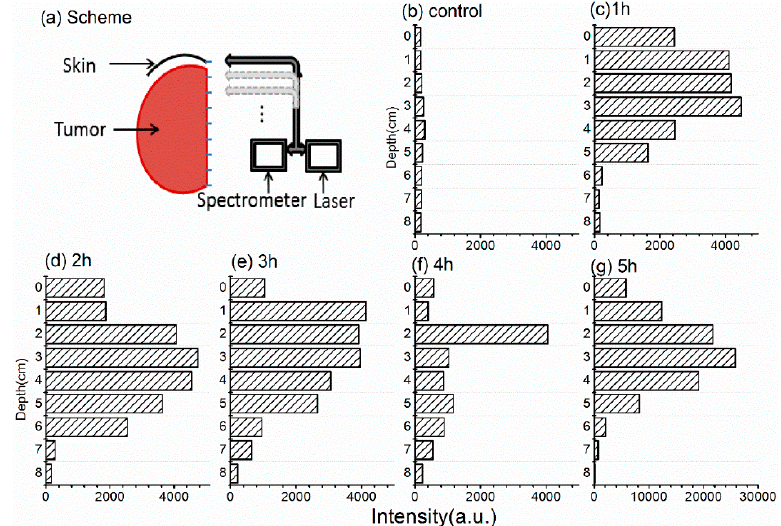
Figure 6. 5-Aminolevulinic acid (ALA) penetration into tumors detected by fluorescence spectrometry. ( a ) Schematic showing detection method. Half of a freshly excised tumor with surface skin attached was placed in a holder and scanned for protoporphyrin IX fluorescence using an optical fiber moving along the vertical axis. Fluorescence was recorded at 1-mm intervals; ( b – g ) Fluorescence intensity at various depths of the tumor in control mice or detected at 1–5 h after application of ALA hydrogel to the skin. Depth of skin is set at 0 mm. Fluorescence intensity was calculated as described in the methods.